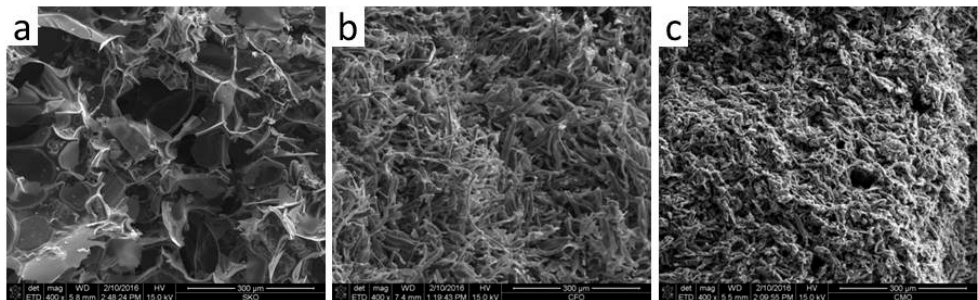
Figure 1. SEM images of the carbonized precursors starch ( a ), cellulose fibers ( b ), microcrystalline cellulose ( c ).